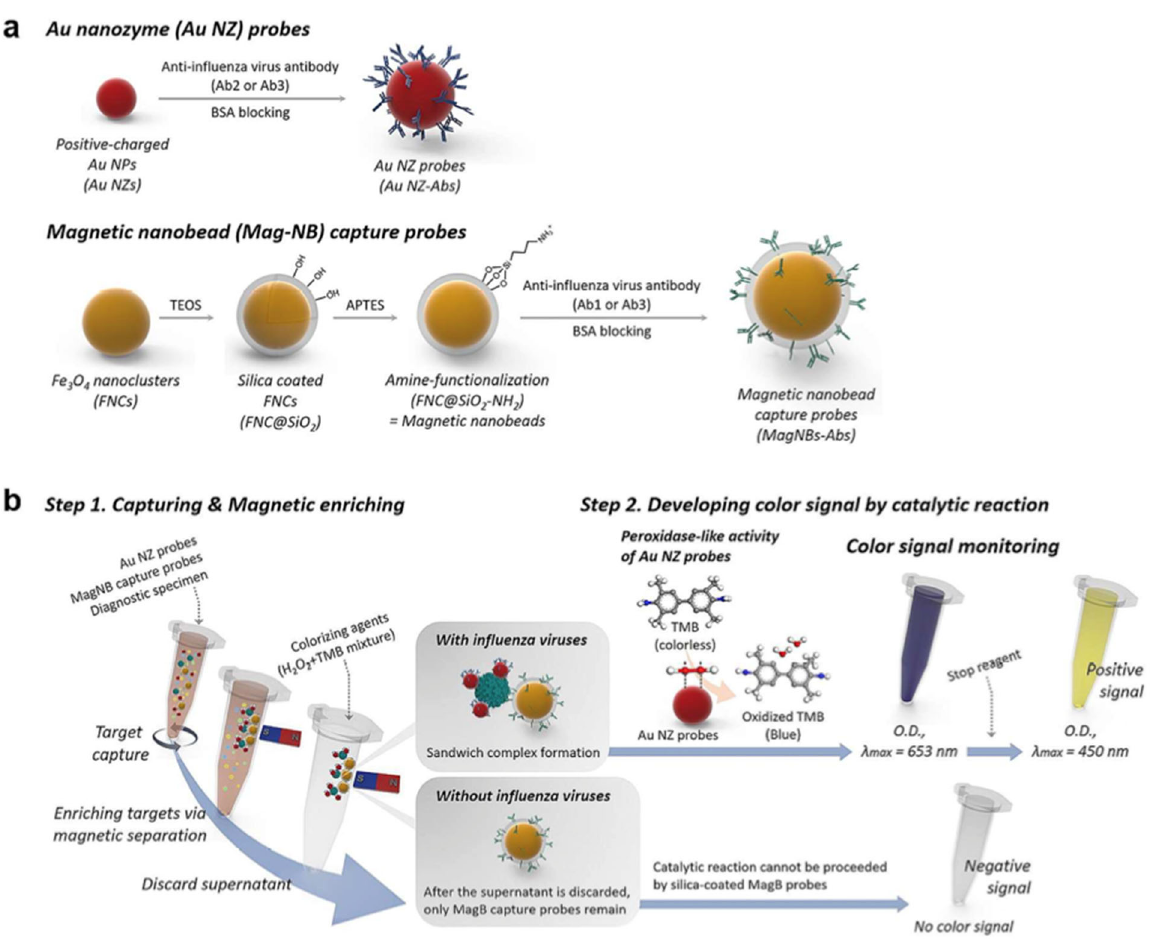
Figure 10. ( a ) Capture probe and Ab-Au nanozyme preparation for a magnetic nanobead-based nanozyme-linked immunosorbent assay (MagLISA). ( b ) Methodology for the determination of Influenza virus using the MagLISA strategy. Reprinted with permission from [56]. Copyright © 2018 American Chemical Society.